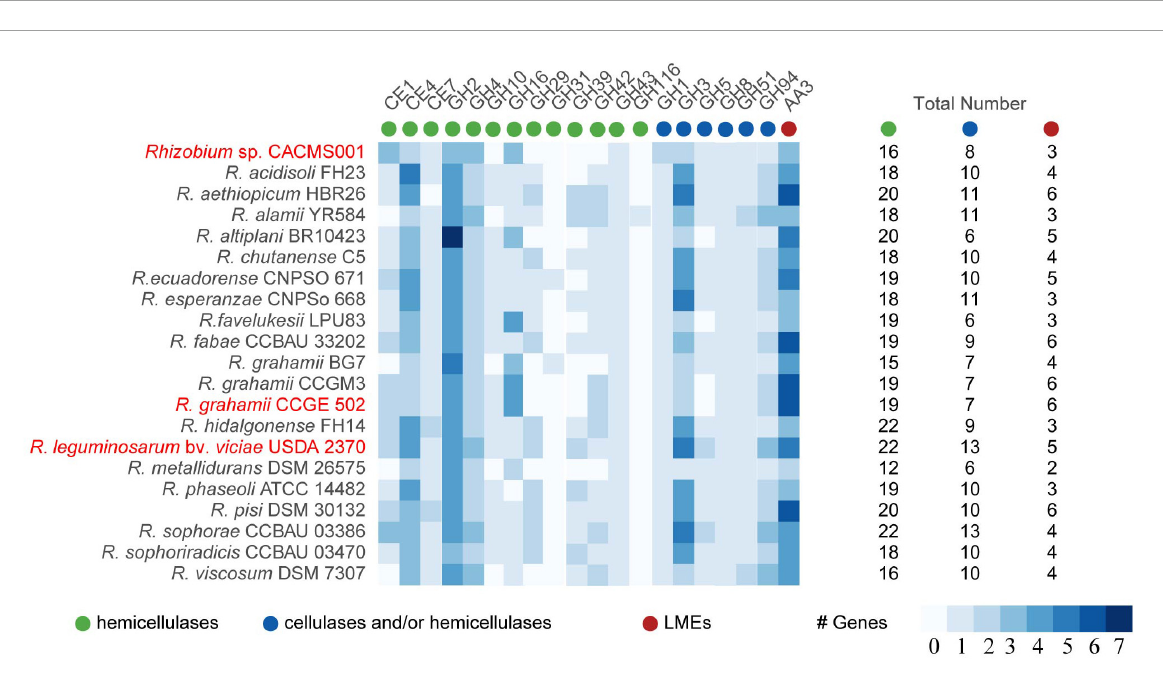
FIGURE6 Lignocellulose degradation enzyme coding genes in Rhizobium species. Red words represent species whose effects on P. umbellatus and A. gallica have been